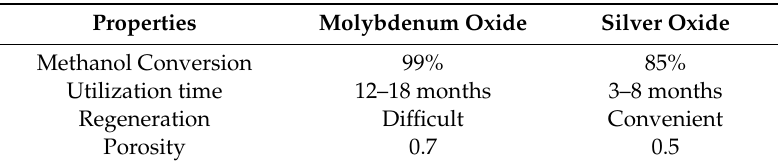
Table 1. Properties of